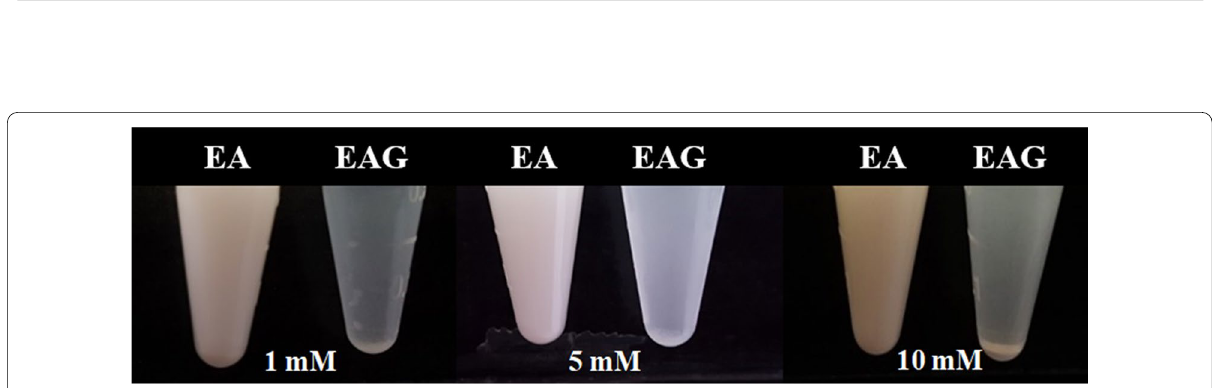
Fig. 3 Water solubility comparison of ellagic acid (EA) and ellagic acid glucoside (EAG) at concentrations of 1, 5, and 10